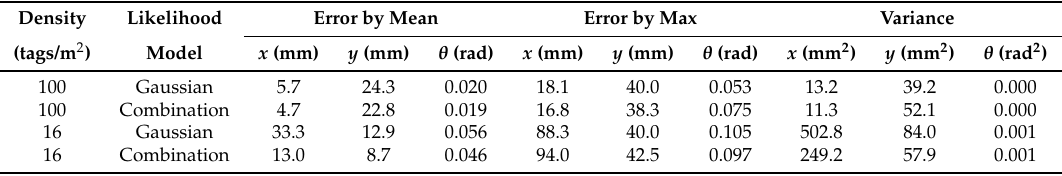
Table 6. Self-localization errors with the eight HF-band RFID reader